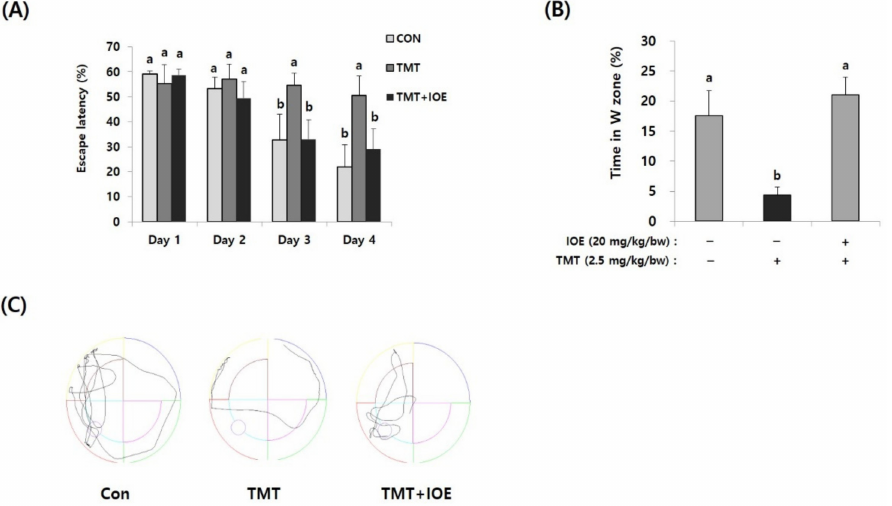
Figure 2. TMT-mediated impairment of long-term memory in mice was attenuated by oral adminis- tration of IOE. The effects of IOE on TMT-mediated long-term memory impairment was estimated by the Morris water maze test. Escape latency ( A ) and time in the W zone (%) at day 5 ( B ) were tabulated ( n = 5). Movement patterns of each group during probe trials ( C ). Data shown are means ± SD. Con: control (non-treated). a: significant differences ( p < 0.05) when compared with